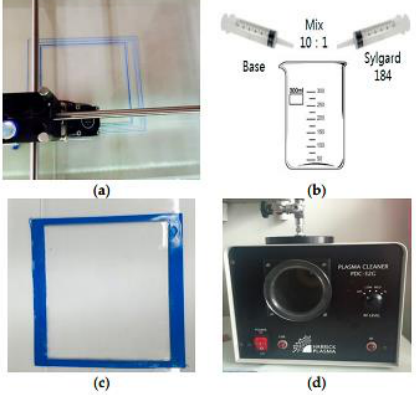
Figure 20. PDMS fabrication process: ( a ) 3D-printed mold for the PDMS substrate; ( b ) mixing the base and curing agent; ( c ) pouring liquid PDMS into the fabricated outline; and ( d ) plasma treatment processing [78].